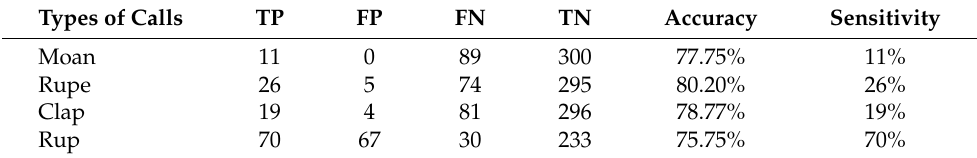
Table 1. Band limited energy detector (BLED) performance for finding specific types of grey seals’ calls. Types of Calls